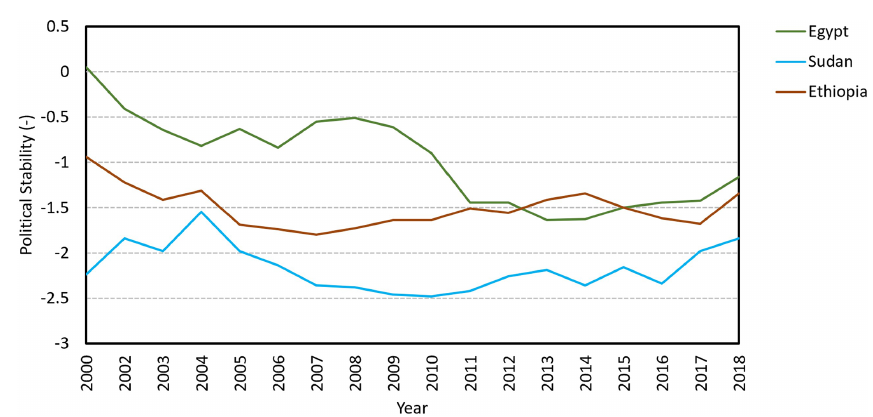
Figure 4. The political stability from 2000 to 2018 of Egypt, Sudan, and Ethiopia ( − 2 . 5 weak; 2.5 strong) (Food and Agriculture Organization Data, 2020b).